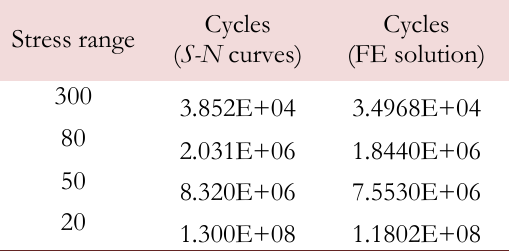
Table 4: Comparison of S-N curve data and numerical results for 3.184 mm initial "calibration" crack